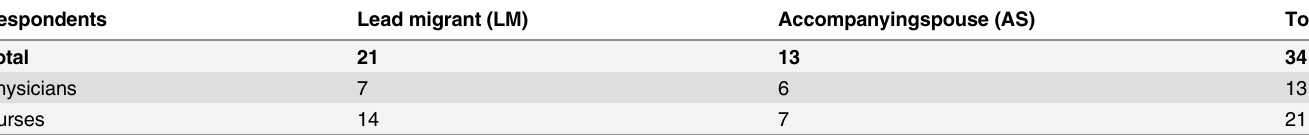
Table 2. Migration status.